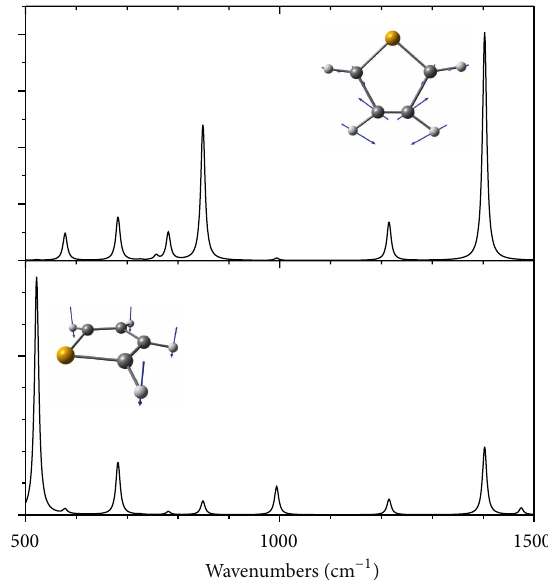
Figure 4: Anharmonic vibrational constants for the C–H stretching mode no. 1 with the vibrational modes ( 𝜒 1,𝑗 , 𝑗 = 1 – 21 ) of C 4 H 4 Se and C 4 D 4 Se. B3LYP/6-311G ∗∗ results. For the mode numbering see Tables 2 and 3.